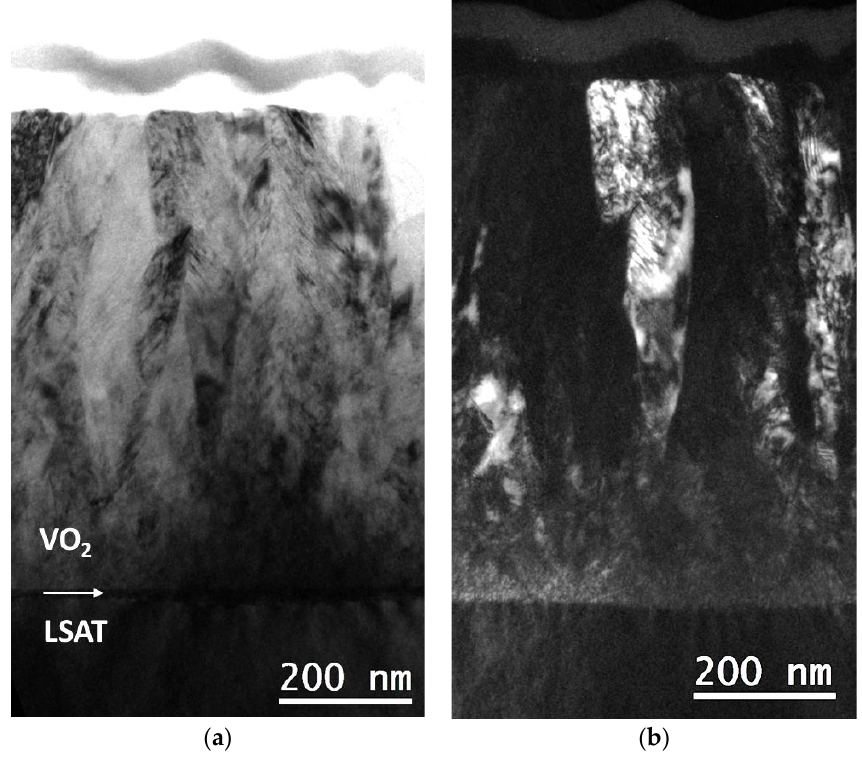
Figure 4. ( a ) BF image taken from S1 revealing the columnar growth of VO 2 thin film grown on LSAT; ( b ) complementary DF image from the same area, obtained with g = 002.